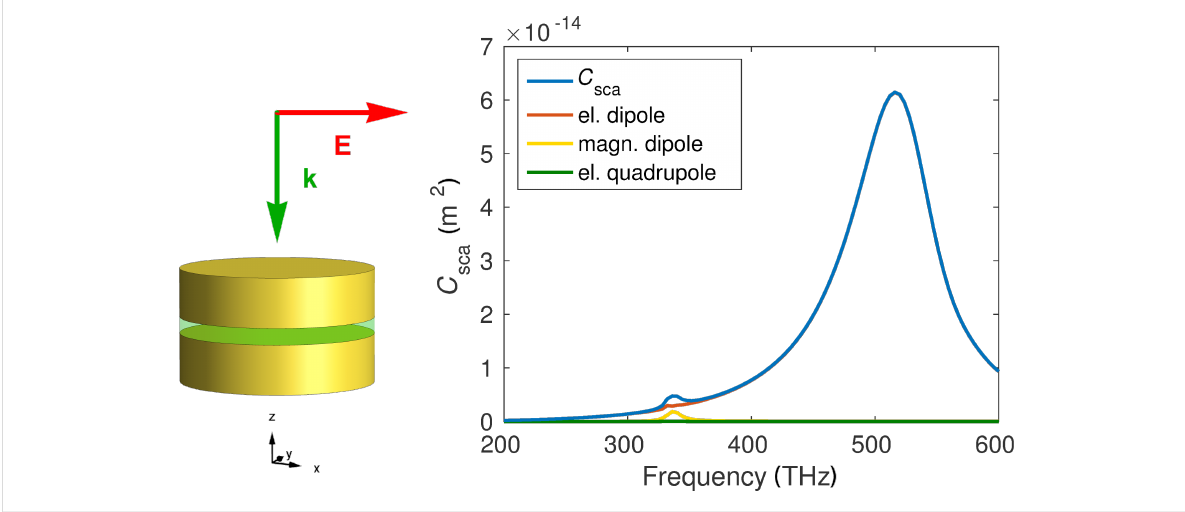
Figure 7: Total scattering cross section (blue) of the sandwich particle and the contributions of different multipole orders. We observe an electric and a magnetic dipole resonance. On the left side we display the geometry and illumination direction of the sandwich. Note that this illumination is only relevant for this particular cross section calculation and the T-matrix is generally independent of the illumination.